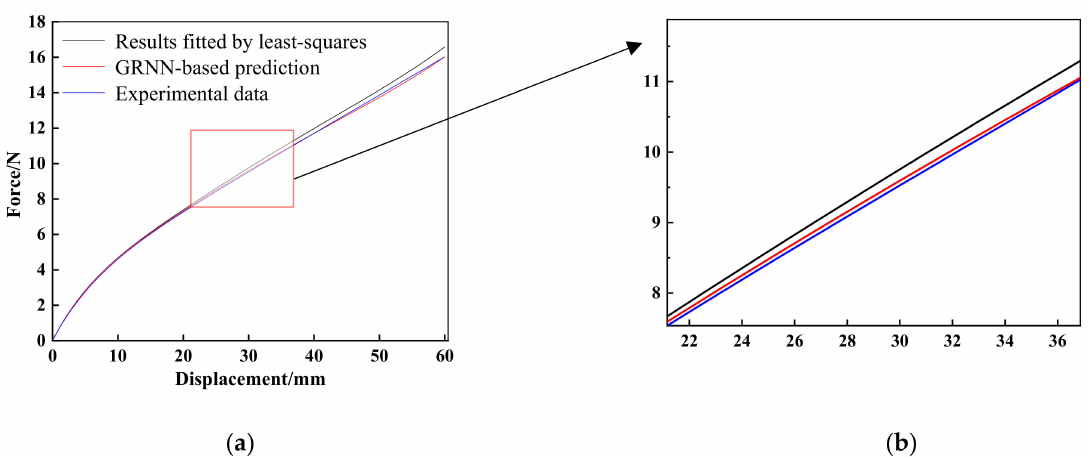
Figure 10. ( a ) Results obtained by using polynomial model ( N = 2); ( b ) The partially enlarged views for specific deformation stages based on polynomial model ( N =